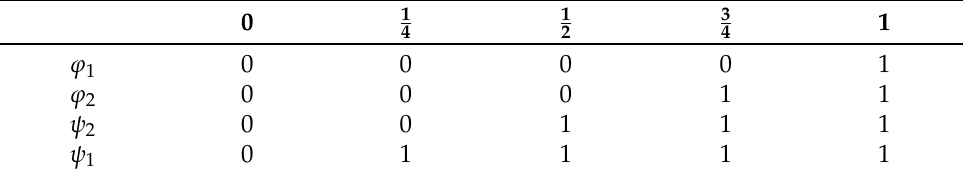
Table 5. Graded operators ϕ 1 , ϕ 2 and its dual graded operators ψ 1 , ψ 2 on L 5 . 1 3 0 1 1 4 2 4 ϕ 1 0 0 0 0 1 ϕ 2 0 0 0 1 1 ψ 2 0 0 1 1 1 ψ 1 0 1 1 1